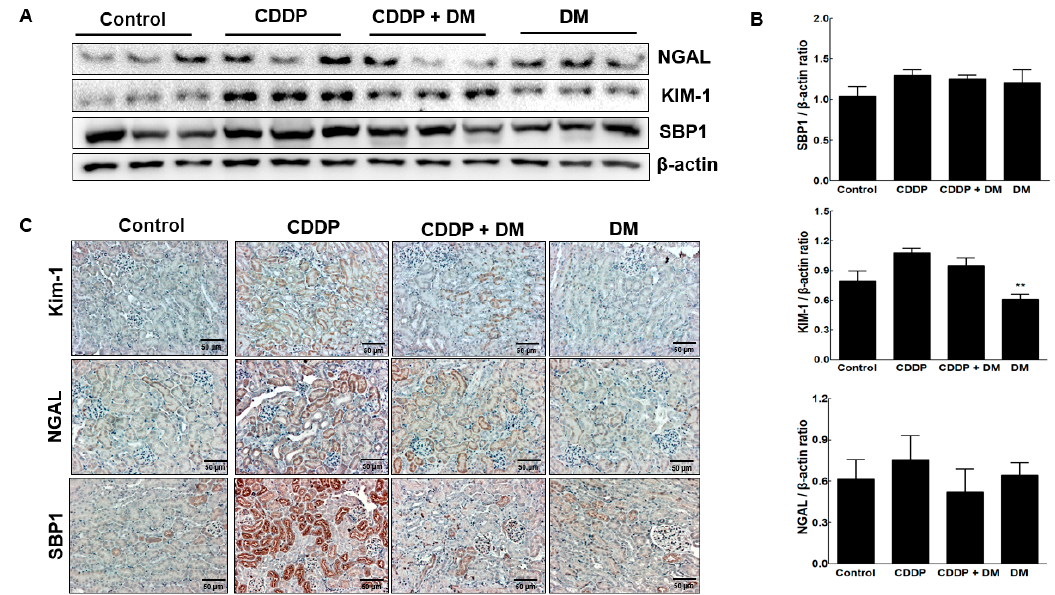
Figure 10. Protective effect of DM on nephrotoxicity biomarkers in CDDP-induced nephrotoxicity in tumor xenograft mice transfected with HCT-116 cells. ( A ) Nephrotoxicity biomarkers were measured in the kidney of mice. Representative Western blots of NGAL, KIM-1, and SBP1 from triplicate experiments are shown. ( B ) Densitometric analysis showed the expression of SBP1, KIM-1, and NGAL in the kidney of mice with CDDP-induced nephrotoxicity. ** p < 0.01 compared to the CDDP-treated group. ( C ) Representative immunohistochemical staining of KIM-1, NGAL, and SBP1 in the kidney of mice with CDDP-induced nephrotoxicity. Original magnification ×100, scale bar: 50 µm.